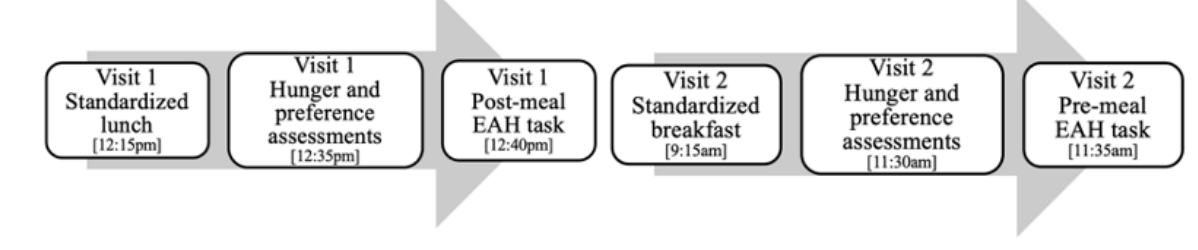
Figure 1. Visual depiction of study protocol.